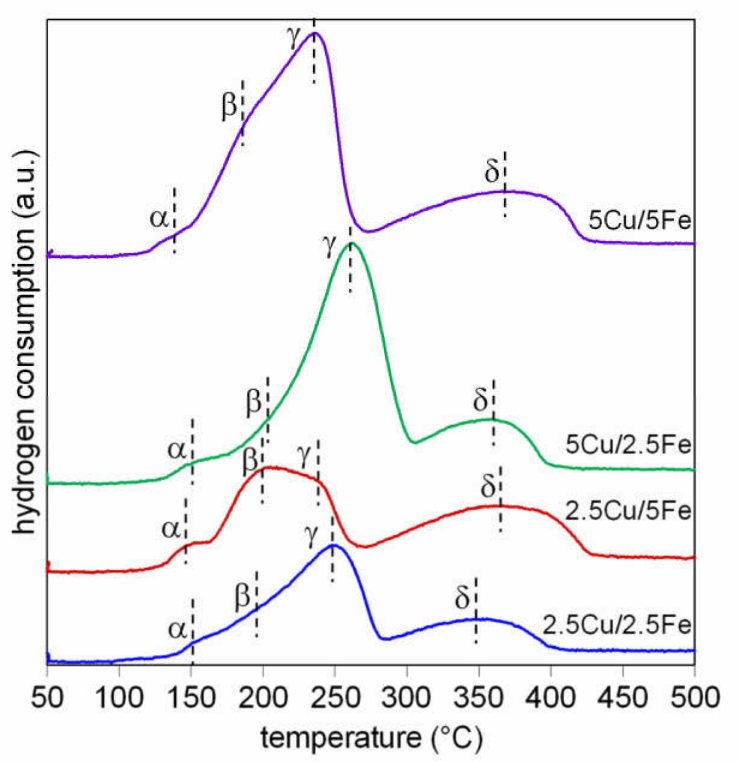
Figure 3. H 2 -TPR profiles of the investigated